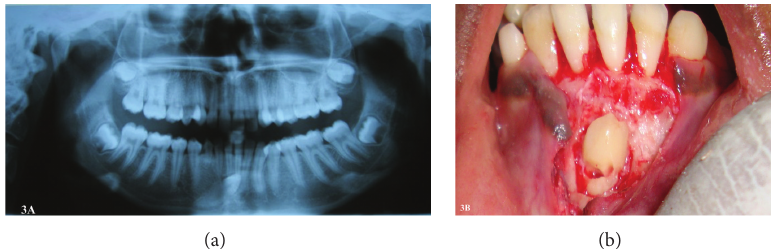
Figure 3: (a) Panoramic radiograph showing transmigrated lower right canine under the apices of the incisors. (b) Surgically exposed transmigrated lower right canine.